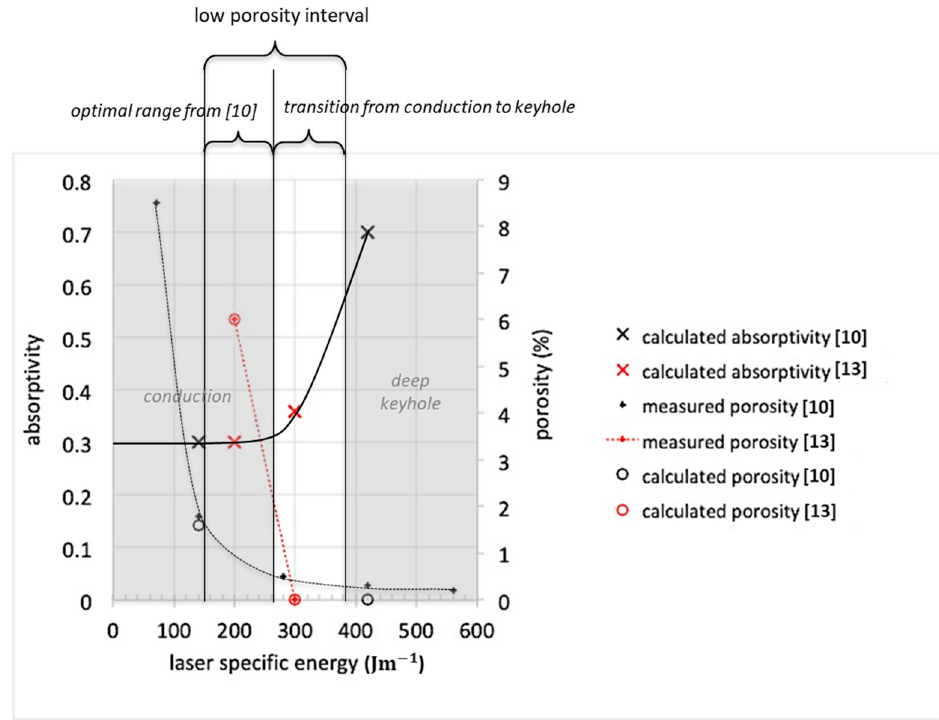
Figure 3. Absorptivity, printing modes’ limits (conduction and keyhole), and porosity, derived through numerical modeling of the processes described in [10,13], referring to steels with 6.7% and 6.9% Si.